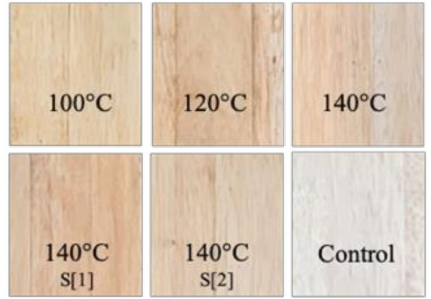
Figure 6. Color differences of Albizia falcataria at different temperatures and pressures.